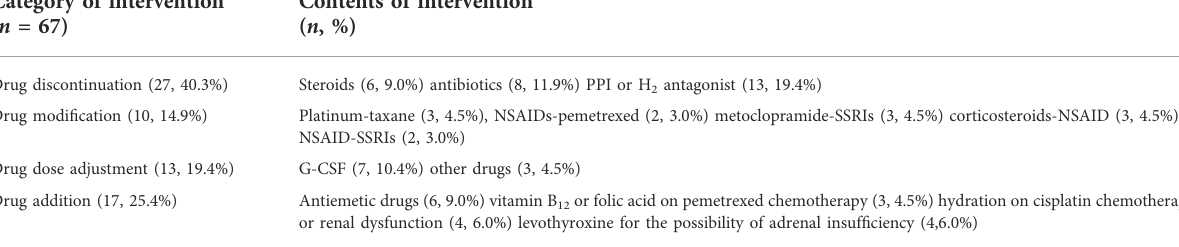
TABLE 2 Interventions after the second-cycle of chemotherapy. Category of intervention ( n =